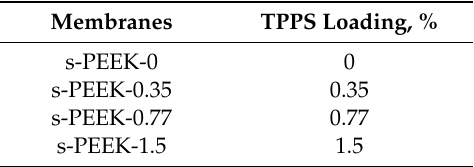
Table 1. Identification labels for membranes under investigation and relative 5,10,15,20-meso- tetrakis (4-sulfonatophenyl)porphyrin (TPPS)